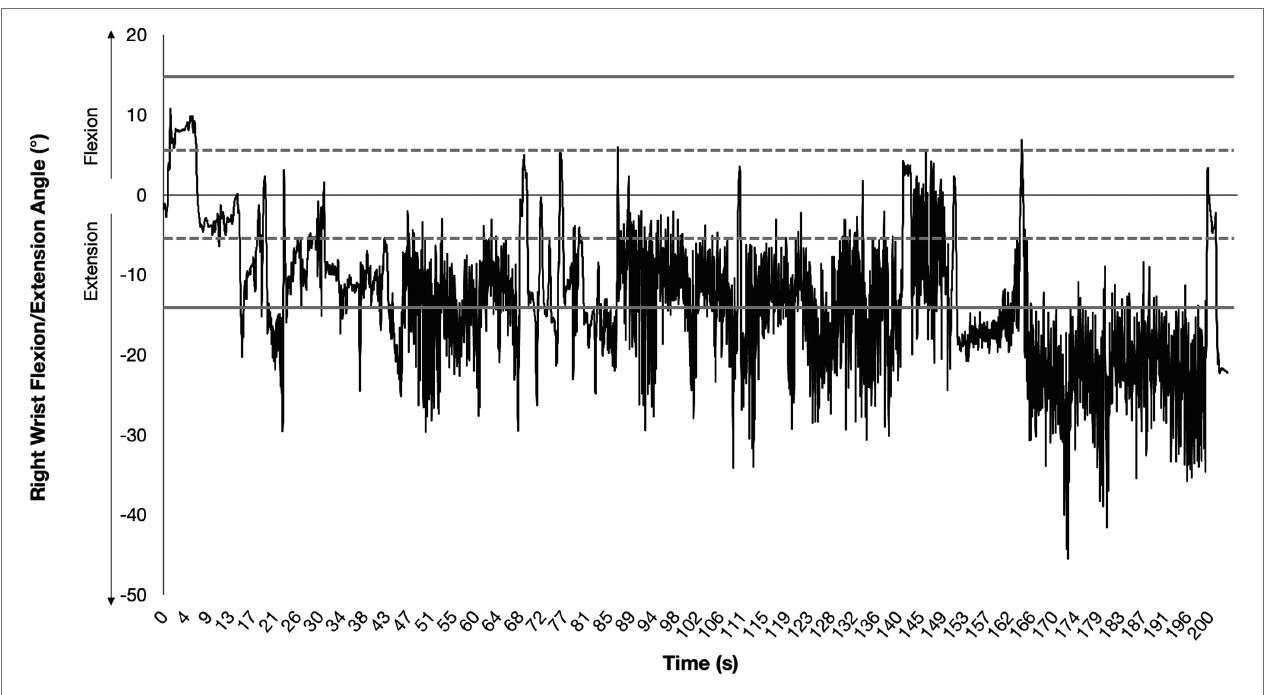
FIGURE 1 | Flexion/extension posture of a drummer’s right wrist over the course of playing a single song (approximately 180 s duration). The horizontal axis represents time, and the vertical axis represents the angle of a drummer’s wrist flexion/extension posture. Flexion angles are positive and extension angles are negative. The area between the dotted lines is the range of wrist flexion/extension angles that were considered “neutral” wrist posture, and the areas between the dotted and thick solid lines is the range of wrist flexion/extension angles that were considered “mildly non-neutral” wrist posture. Participants spent a substantial amount of time with their wrists extended well beyond this range, clearly in the territory that would be considered non-neutral and even